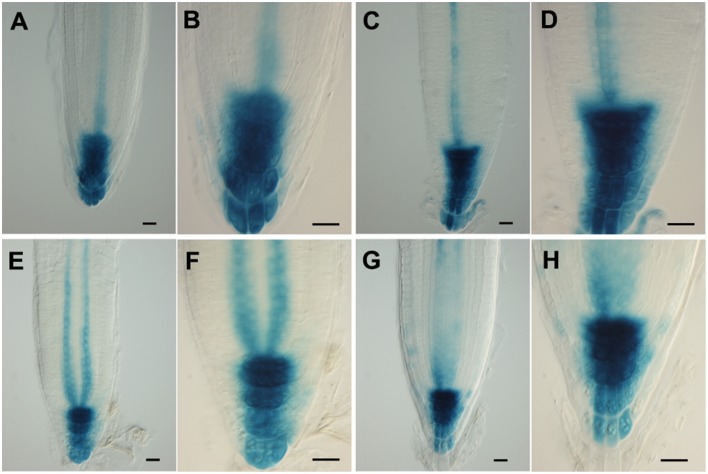
(A–H) Patterns of expression of an auxin-responsive promoter (DR5) in Arabidopsis root tips, ± salt treatment. Using the DR5GUS reporter in roots treated with 150 mM salt for 3 h (A–D) or 24 h (E–H) in order to reveal auxin distribution. (A,B,E,F) control; (C,D,G,H) plus salt. Scale bar = 20 μm. n = 10 roots for control and for each treatment.